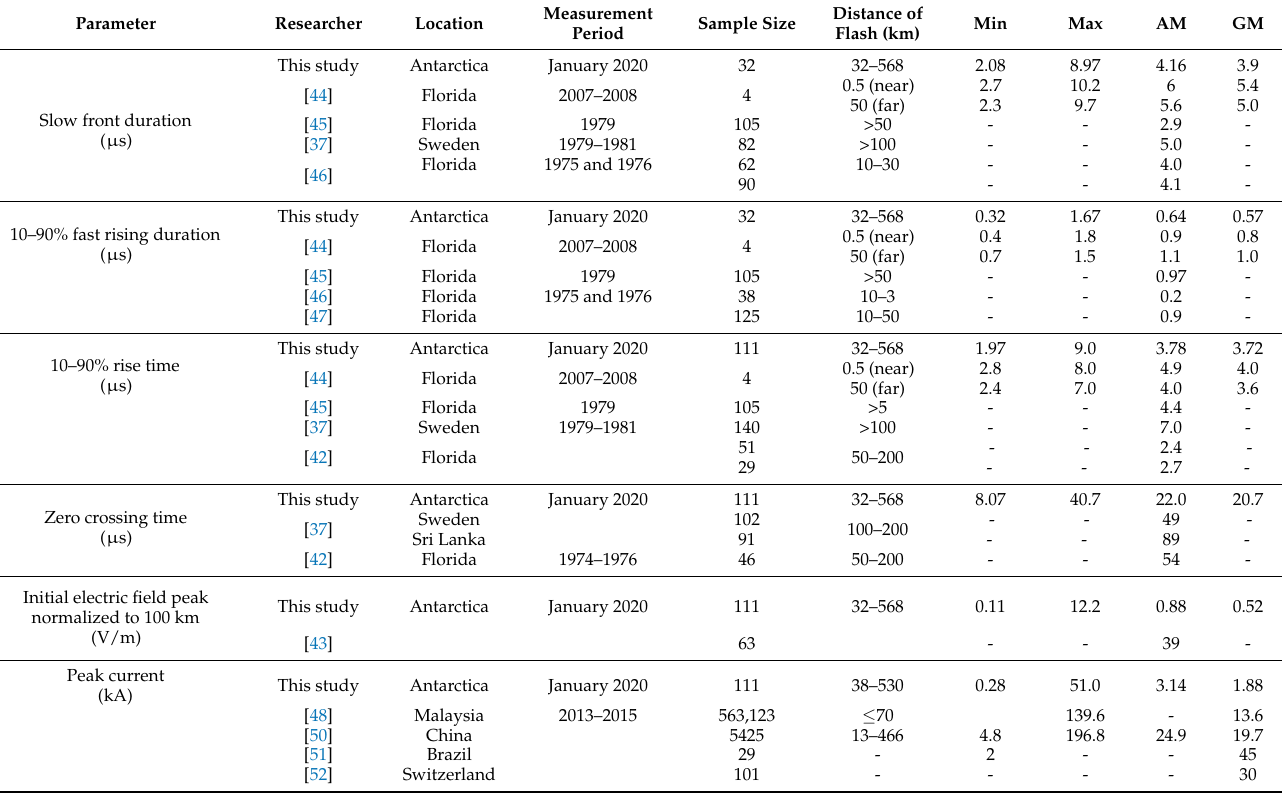
Table A7. Comparison on return strokes parameters between previous studies for − CG